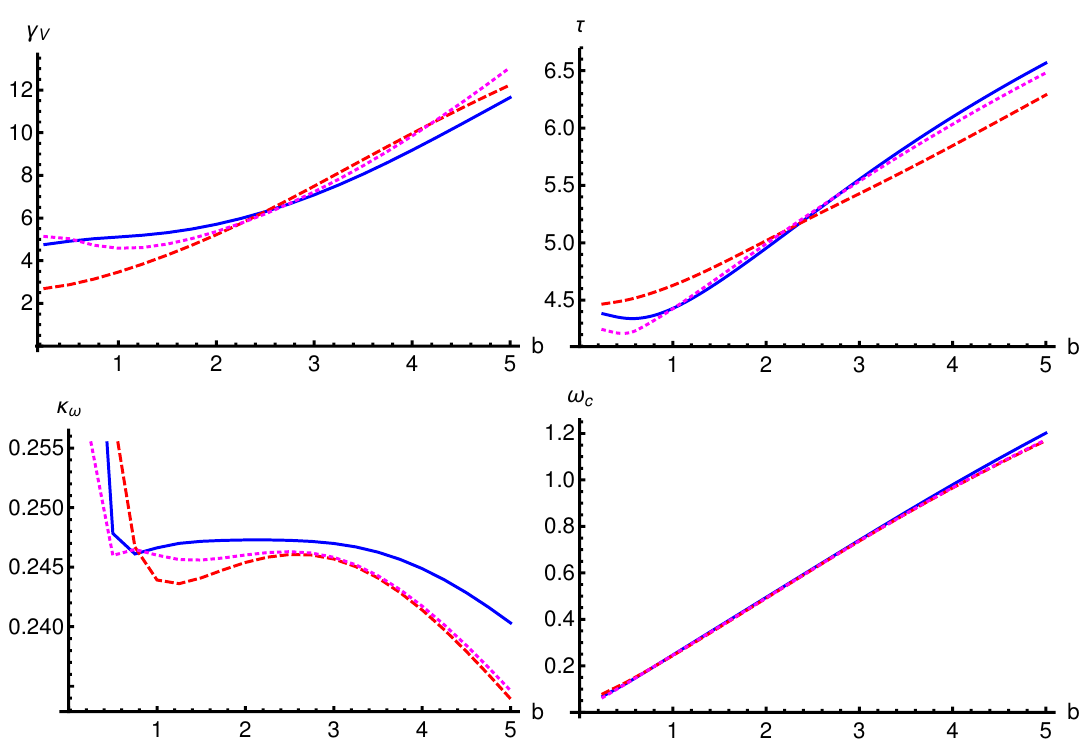
Figure 5 . The three fit parameters ( γ V , τ , κ ω ) and the cyclotron frequency ω c = κ ω b for homogeneous optical conductivities as a function of b . The solid blue, dashed red, and dotted magenta curves were fitted to the data for the longitudinal conductivity, the Hall conductivity, and to both the conductivities simultaneously,